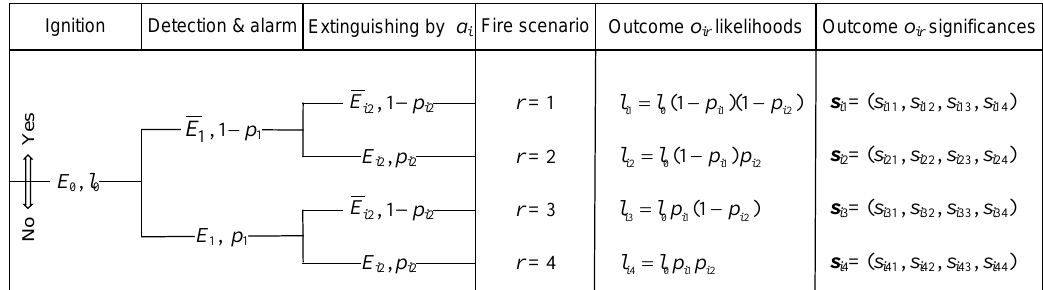
figure 2. Simplified event tree diagram for a fire in a sprinklered building with a fire detection and alarm